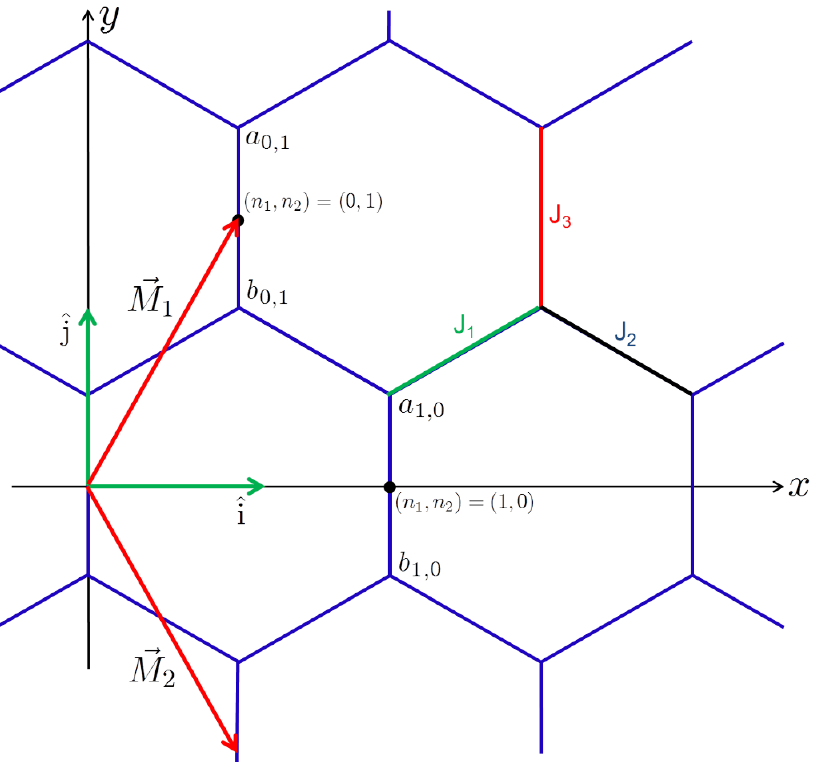
Figure 1 . The honeycomb lattice on which the Kitaev model (2.17) is de(cid:12)ned. J 1 and J 2 correspond to the interaction strength of left and right horizontal bonds, respectively, while J 3 de(cid:12)nes the interaction strength for the vertical bonds. The fermions a ~n and b ~n live on the sites at the top and bottom of the vertical bond labeled by ~n